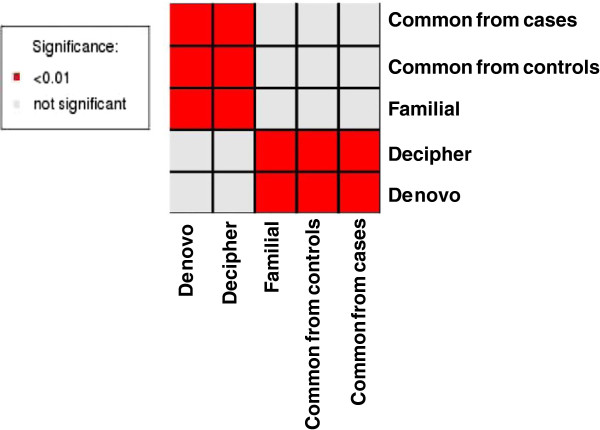
Comparison of weighted median number of miRNAs/Mb in different CNV subgroups.